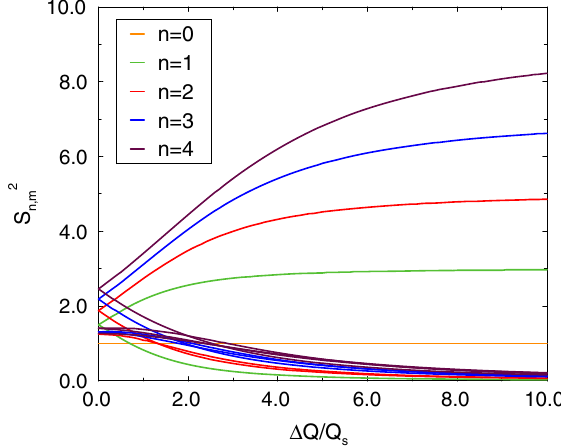
FIG. 2. Normalizing coefficients of the boxcar bunch. The rising lines refer to the case m ¼ n .